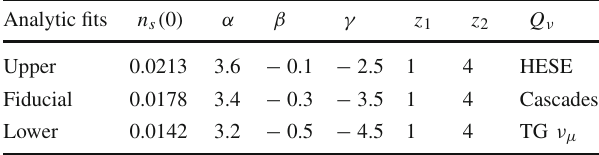
Table 1 Model parameters for the the source density n s , Eq. (5), values taken from [79]. The last column reports the neutrino data we adopt to compute the source neutrino spectrum Q ν in the three cases Analytic fits